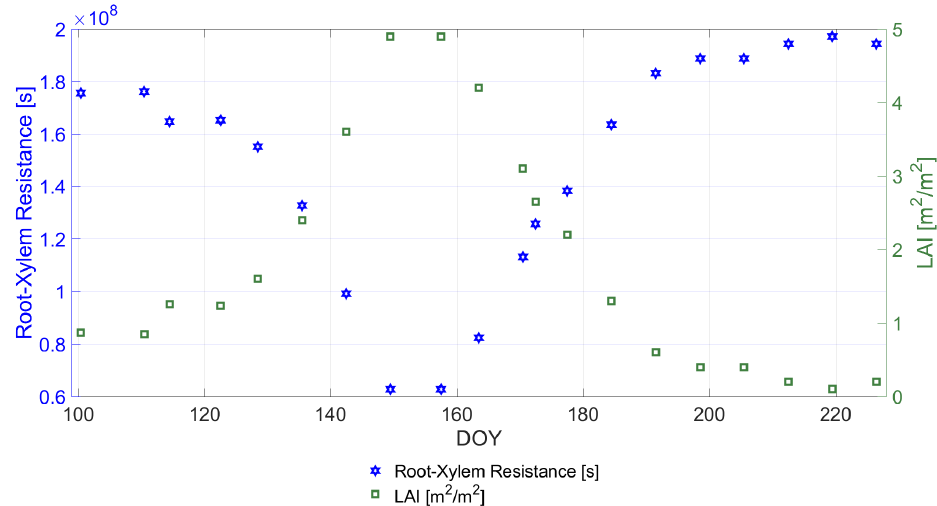
Figure 6. Comparison of the in situ-measured leaf are index LAI [m 2 m − 2 ] and the calculated root-xylem resistance R RX [s] deduced from Lynn and Carlson (1990) along days of year (DOY).